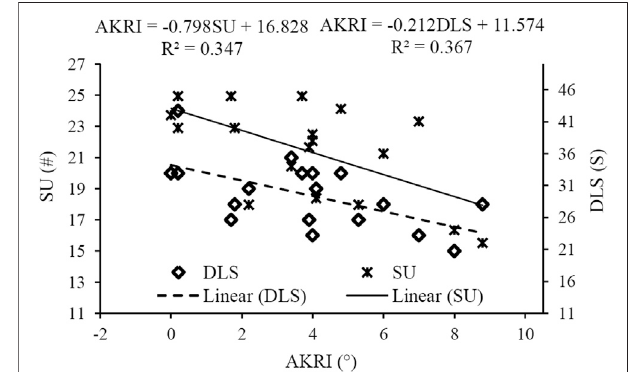
FIGURE5| Resultsoflinearregressionanalysesoftheangularmotionof the knee internal rotation (AMKR) with the fi ve core-related measurements which included dominant extremity single-leg hop distance normalized by body height (DLH/H), sit-ups in 20 s (SU), dominant extremity single-leg stancetime(DLS),trunk fl exionandextensionrangeofmotion(TFE),andtrunk extensor endurance (EE).